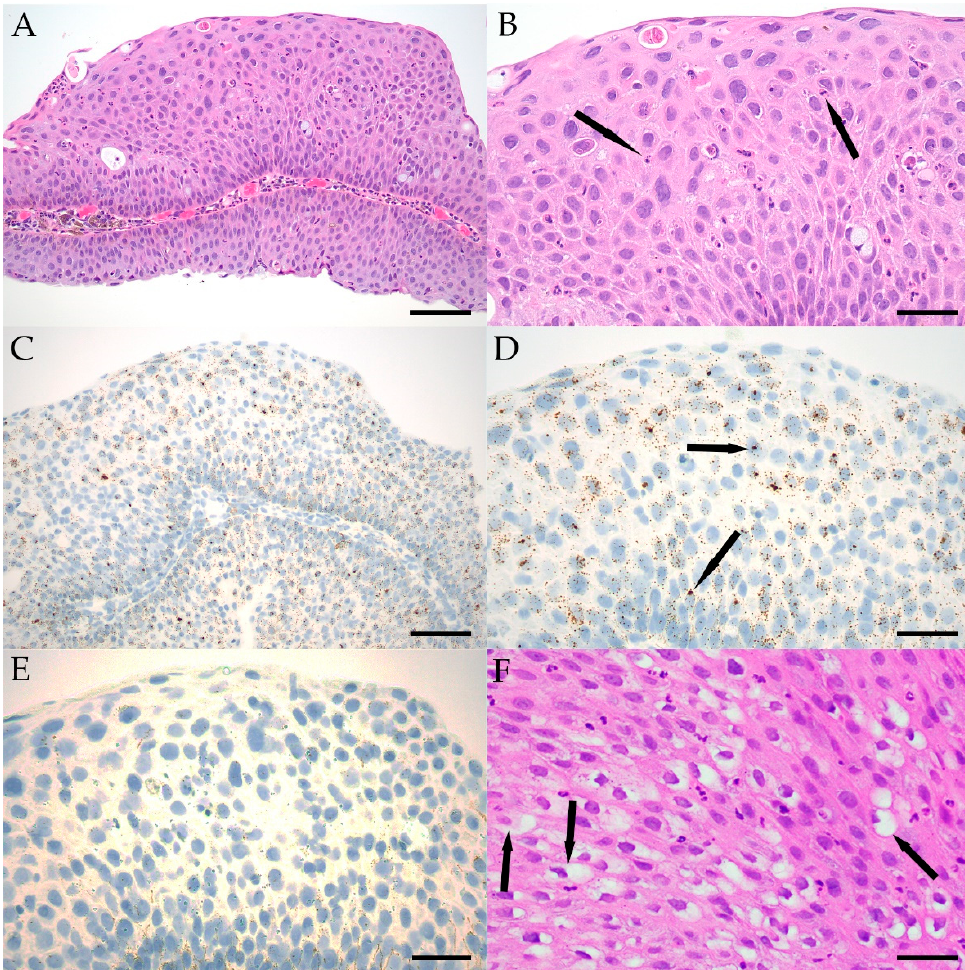
Figure 4. H&E-stained section of Case 1, a conjunctival papilloma demonstrating reactive epithelial atypia associated with inflammation ( A ) (scale bar: 50 μ M). Reactive atypia and mixed inflammation characterized by neutrophils (arrows) and fewer lymphocytes and plasma cells within the epithe- lium from Case 1 at higher magnification ( B ) (scale bar: 25 μ M). HPV in Case 1 was confirmed with RNA in-situ hybridization, with diffuse LR HPV in ( C ) (scale bar: 50 μ M) and shown at higher mag- nification with dot-like foci of signal, some of which coalesced into larger masses (arrows) ( D ) (scale bar: 25 μ M). HR HPV was not detected in these same epithelial cells ( E ) (scale bar: 25 μ M). Diffuse koilocytosis (arrows) in the well-differentiated epithelium of a recurrent LR HPV-positive papil- loma from Case 14 ( F ) (scale bar: 25 μ M). 2.4. Patient Follow-Up and Atopic History Patients returned for follow-up care in 17/33 (52%) papilloma cases, 8/16 (50%) CIN/cCIS cases, and none of the invasive SCCs. The length of follow-up (mean ± SD) was 605 ± 1219 days and 887 ± 1534 days for papilloma and CIN/cCIS cases, respectively. Re- currence was noted in only one case (Case 14) following an initial diagnosis of an HPV-